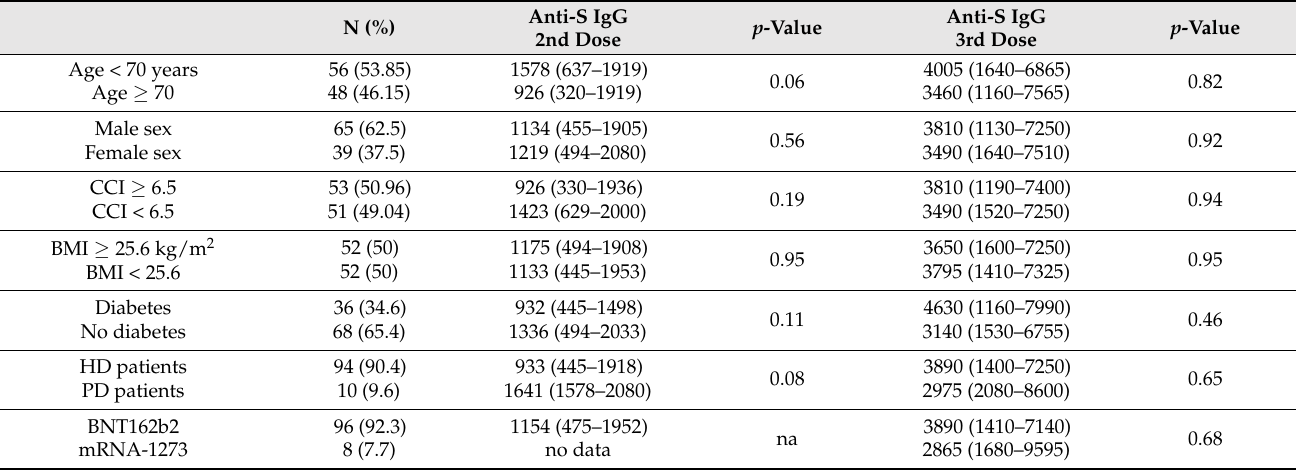
Table 4. Strata analyses of anti-S antibody (BAU/mL) titer after the second and third dose in IN-D patients.